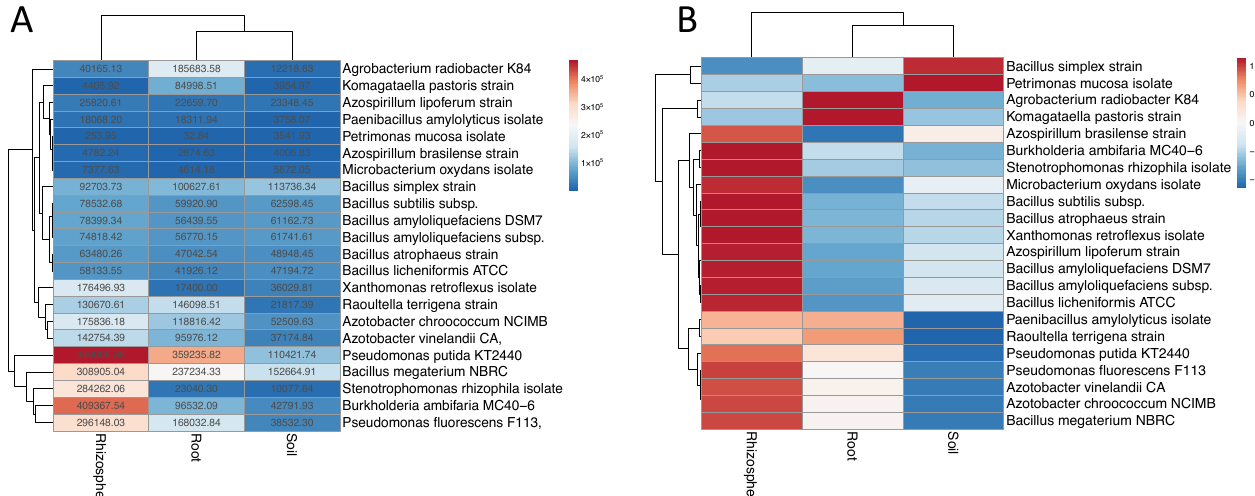
Figure 1. Heatmaps of fragment recruitment counts on 22 plant growth promoting (PGP) microbial genomes in three different environments (Rhizosphere, Root, and Soil according to descriptions provided in the metadata of the analyzed datasets). ( A ) The heatmap was plotted using normalized fragment recruitment counts (normalized to the total number of sequence reads of each environment). Both, rows and columns, are clustered using the Euclidean distance and average linkage method. ( B ) Rows of the heatmap are scaled using unit variance scaling (Autoscaling). Both, rows and columns, are clustered using the Euclidean distance and average linkage method. Please note that the different order of species designations between panels A and B is due to the applied cluster